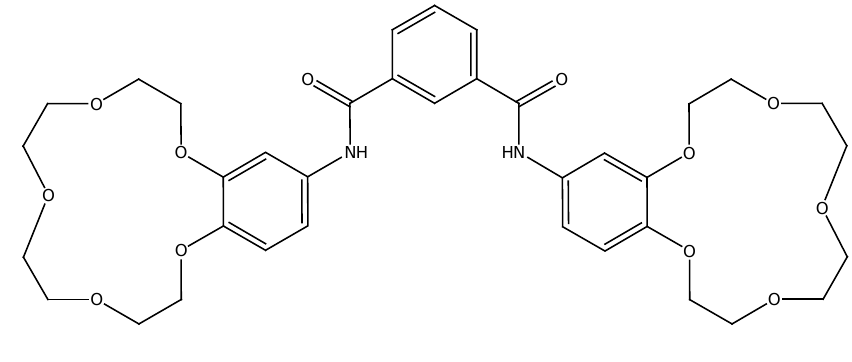
Figure 32. Bis(crown ether) ionophore, R = CO(CH